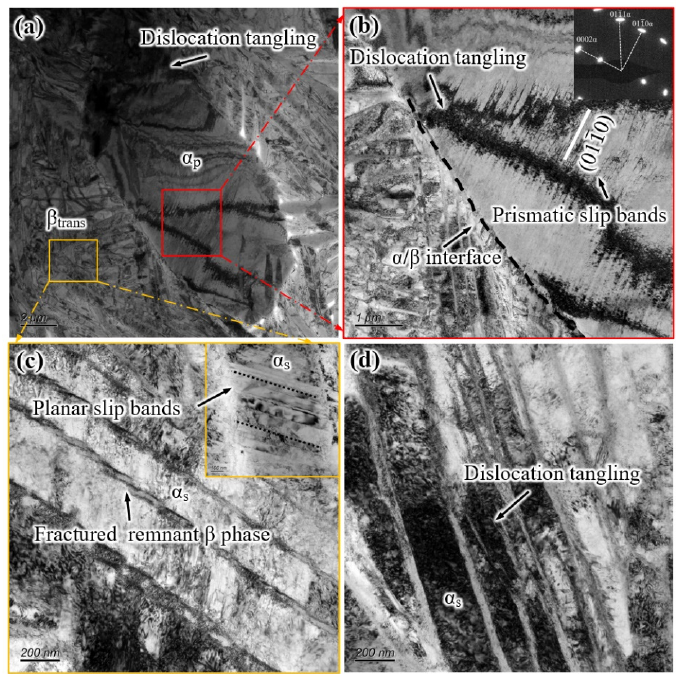
Figure 10. Deformation behavior of the tensile specimen with the EM: ( a ) dislocation tangling in equiaxed α p phase, ( b ) prismatic slip bands in equiaxed α p phase, ( c ) fractured β r lamellae, and ( d ) dislocation tangling in α s lamellae.